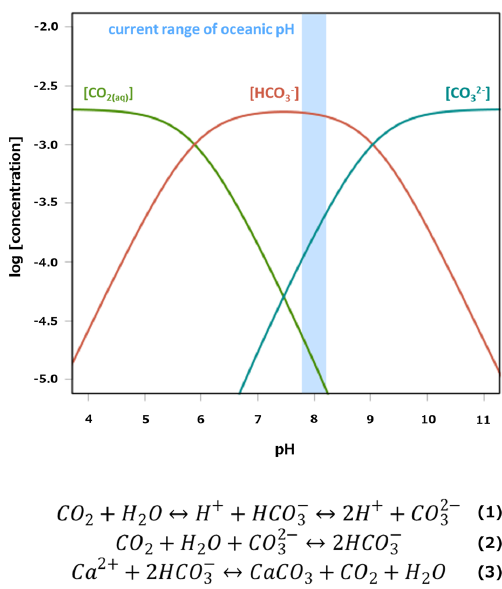
Figure 2. Bjerrum plot created according to equations reviewed in Sarmiento and Gruber (2006) and Zeebe and Wolf-Gladrow (2001) as well as main reactions of carbon chemistry referred to in this